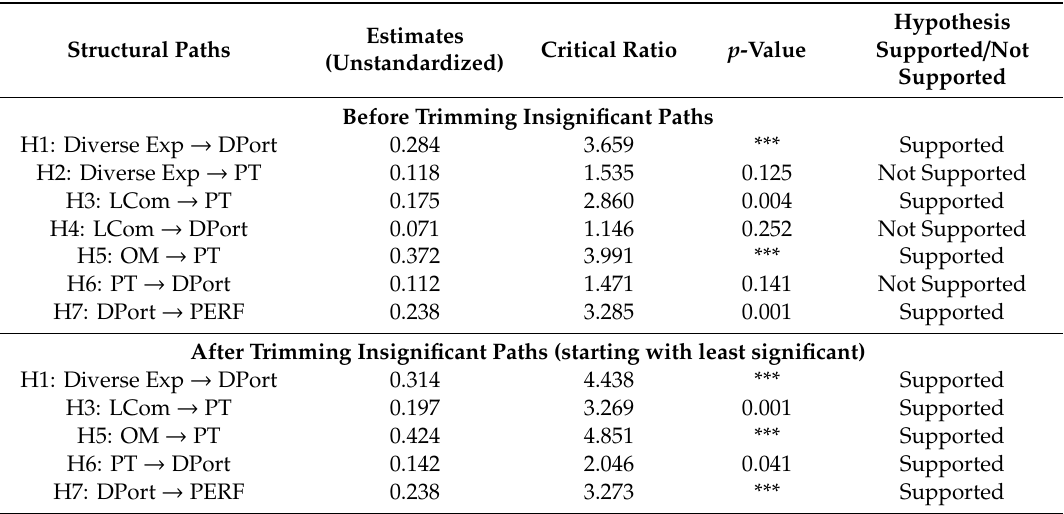
Figure 2. Results of the Hypothesized Model (Standardized Estimates). Table 5. Results: Hypotheses